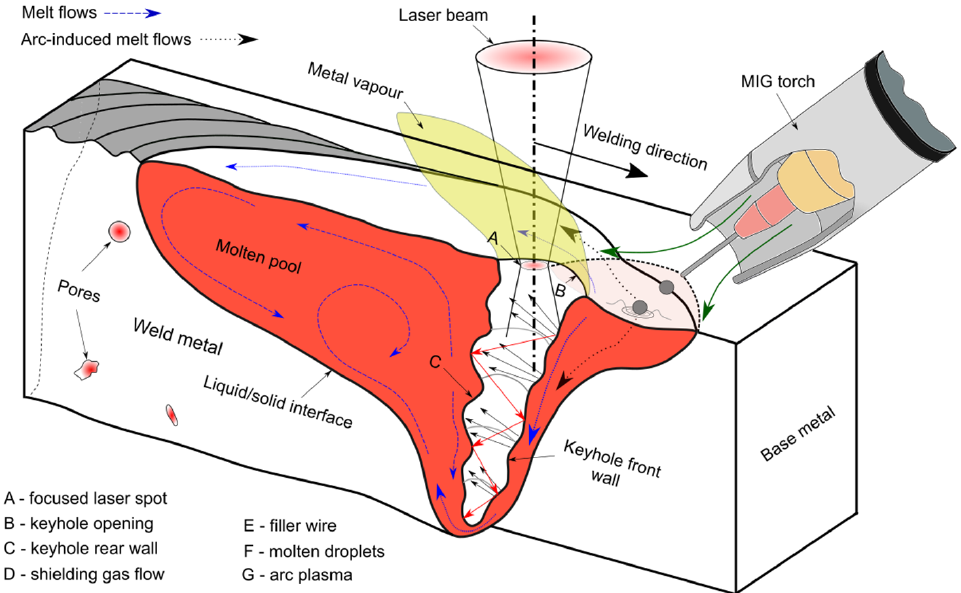
Figure 9. Representation of LAHW in paraxial configuration with leading arc/trailing laser setup and their melt flow behaviours. Melt flows are based on [30,38,40,50,59,99,114–129]. Generally, Nd:YAG-MIG hybrid welding is not suitable to weld thick aluminium due to power limits and poor BPP (see Table 3). CO 2 lasers has low absorption due to longer laser wavelength (10 µ m) and are no longer widely produced. The develop- ment of high-power fiber/disk lasers has changed the situation enabling single-pass LAHW exceeding a penetration depth of 8.0 mm with improved welding speeds due to improved